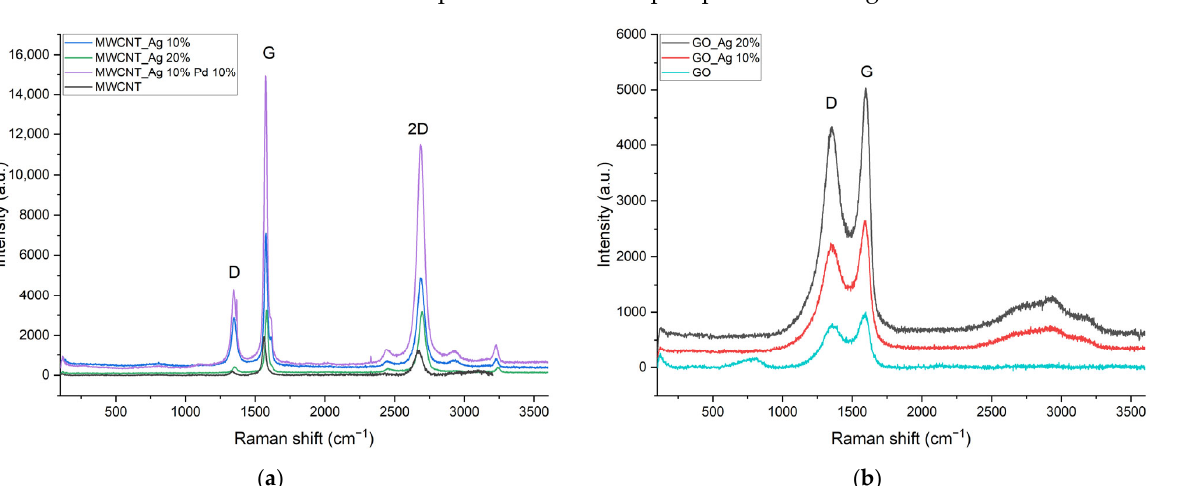
Table 2. Results of the Raman spectra of the synthesized catalysts and initial carbon supports.